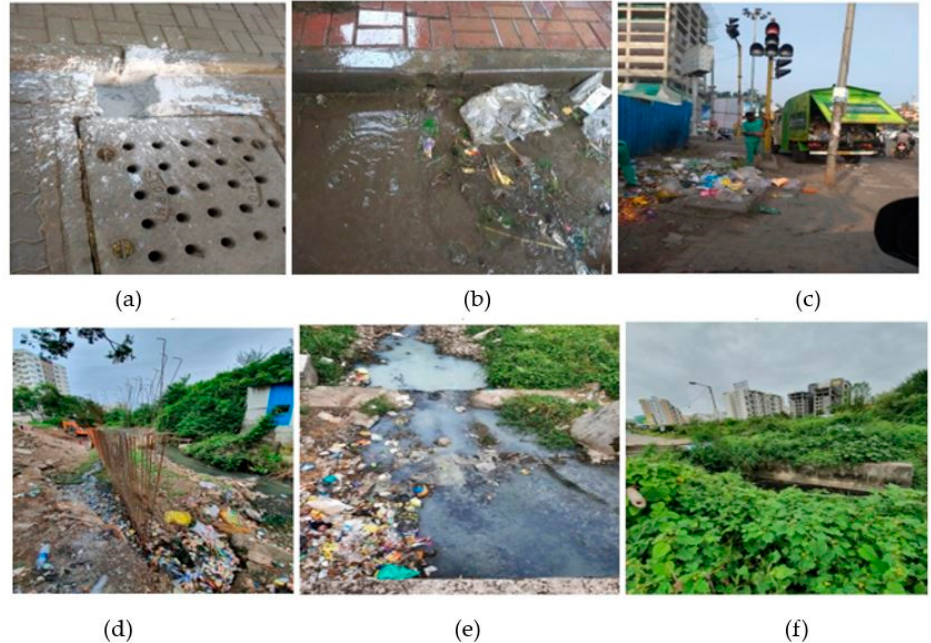
Figure 5. Study area images ( a ) Throwing of chemicals/paints in the stormwater drain, ( b ) Choking of drains due to waste on road, ( c ) Improper solid waste management practices, ( d ) Construction activity near the stormwater drain, ( e ) Liquid waste in the open stream, ( f ) Sampling station inaccessible due to weeds growth.